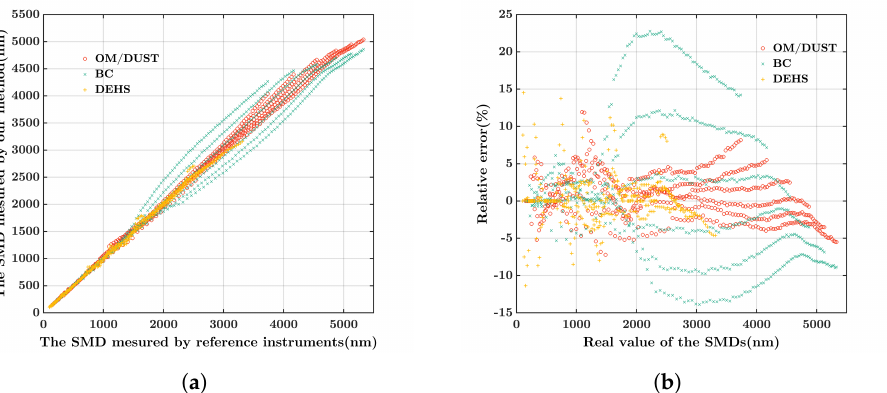
Figure 8. The performance of our prototype sensor evaluated by the simulation experiments. ( a ) The contrast between SMD real and SMD test . ( b ) The relative measurement error of aerosol